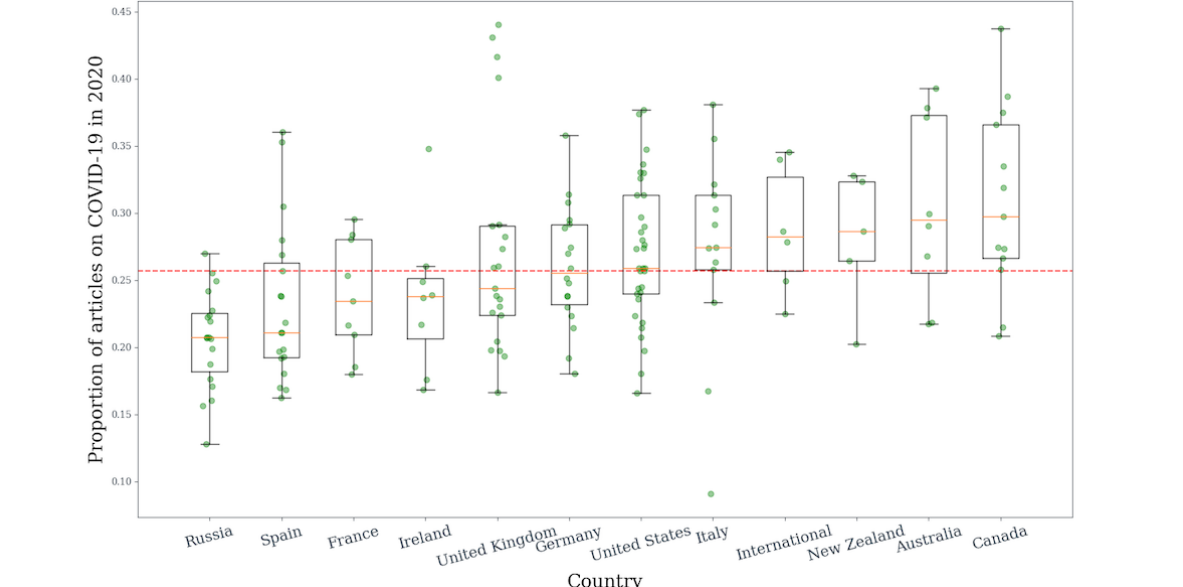
Figure 1. The extent of coronavirus coverage in 2020. We calculated the proportion of all COVID-19 articles as the proportion of all front-page articles. Proportions were calculated for each online news source separately and then aggregated at the national level. The green points represent the individual coverage of each online news source. The yellow line in each box represents the median; the upper and lower whiskers represent the 75th and 25th percentiles, respectively. The red dotted line indicates mean proportion across all online news